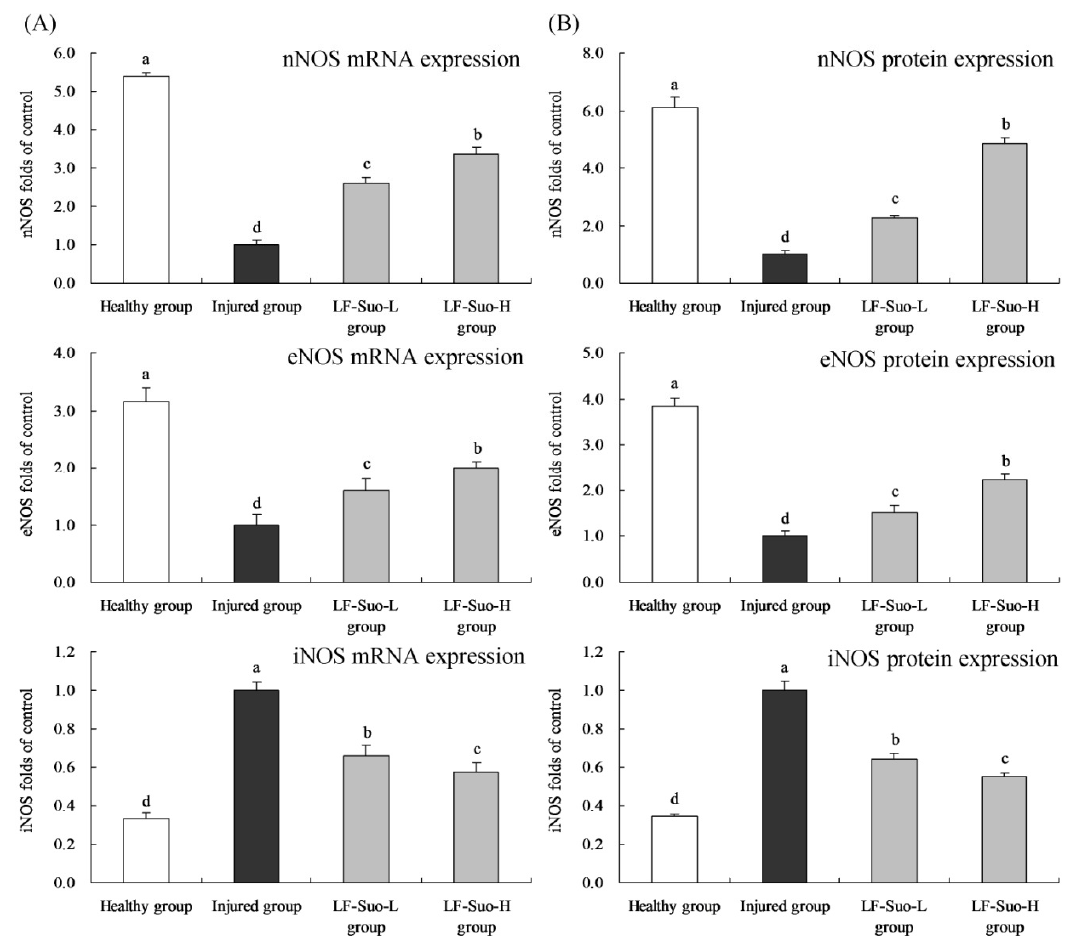
Figure 6. nNOS, eNOS, iNOS mRNA ( A ) and protein ( B ) expression of studied mice. Fold ‐ ratio: gene expression/GAPDH ( β‐ actin) × injured group numerical value (injured group fold ratio: 1). a–d Mean values with different letters in the same column are significantly different ( p < 0.05) according to Duncan’s multiple ‐ range test. LF ‐ Suo ‐ L, Lactobacillus fermentum Suo (0.5 × 10 9 CFU/kg b.w.); LF ‐ Suo ‐ H, Lactobacillus fermentum Suo (1.0 × 10 9 CFU/kg b.w.).